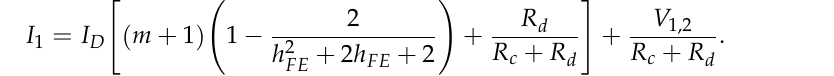
Figure 5. Two-terminal NDR circuit with multiple-output improved Wilson current mirror. Analysis of (3), (5), and (7) shows that the total current I 1 in the NDR region is a func- tion of the drain current of transistor T 0 , which is an n-channel FET. For the existence of